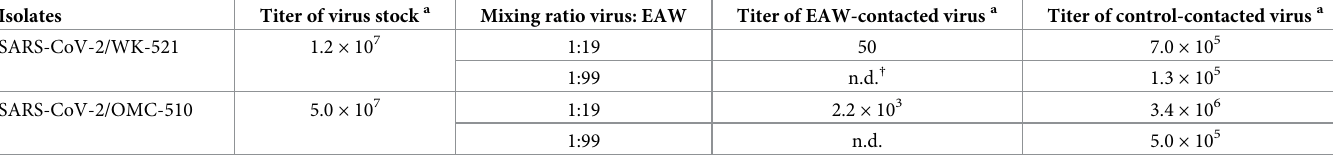
Table 5. Inactivating activity of EAW against SARS-CoV-2.